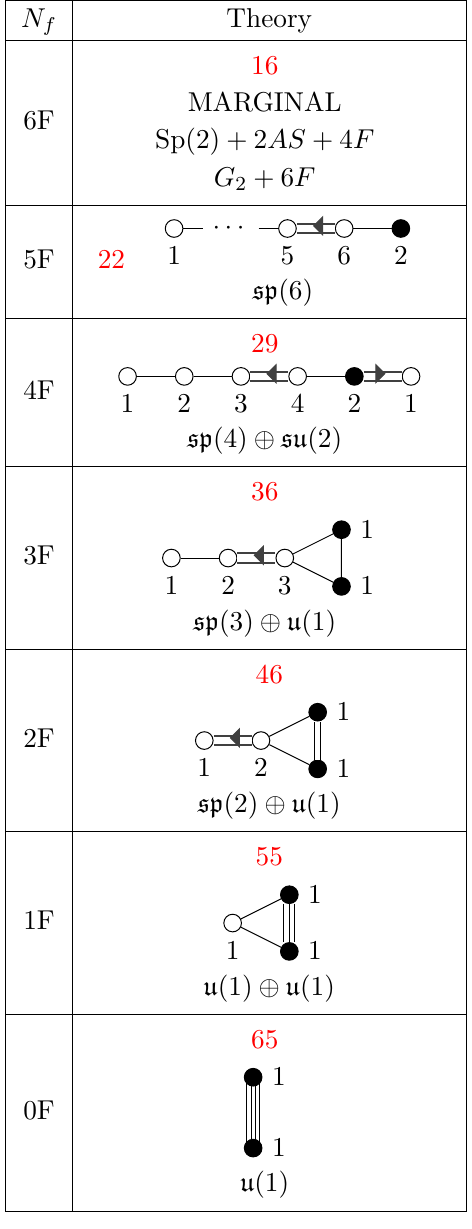
Table 11 . Rank 2 decoupling tree continued: G 2 theories with N f